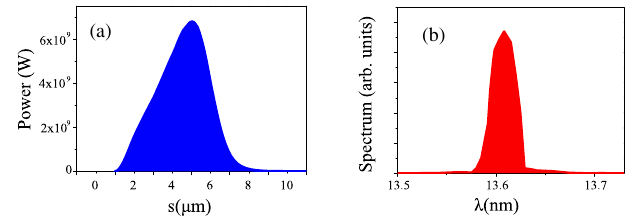
FIG. 2. Signal (a) and spectrum (b) of the intracavity power of the oscillator at saturation.